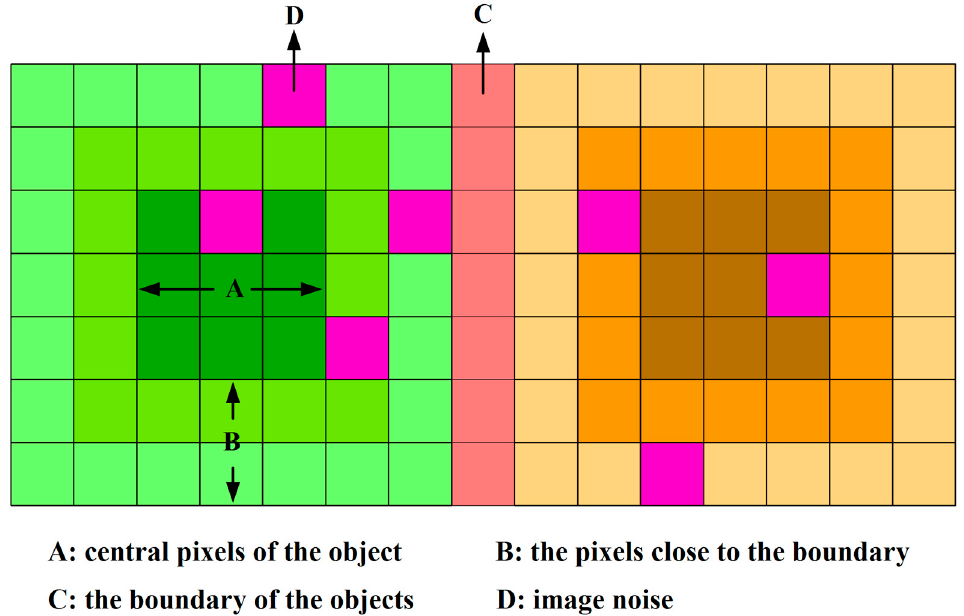
Figure 1. Spatial distribution of the different types of pixels in the image objects. (The difference in pixel color represents the difference between the features of the pixels.).